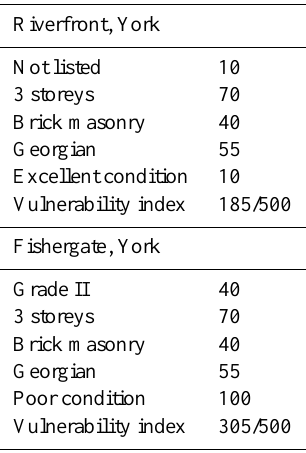
Table 4. York vulnerability index